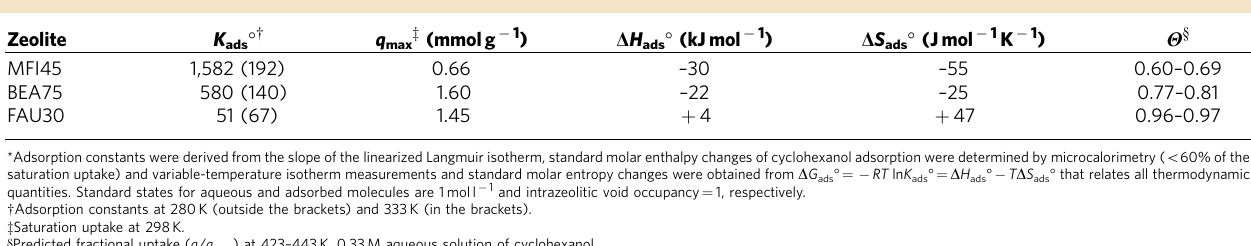
Table 1 | Adsorption parameters for cyclohexanol uptake from aqueous solutions into three zeolites (denoted with the respective Si/Al ratio).* Zeolite